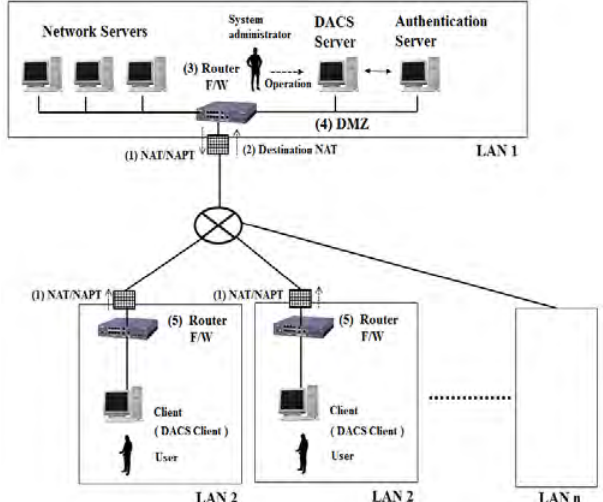
Figure 10 Basic System Configuration of wDACS